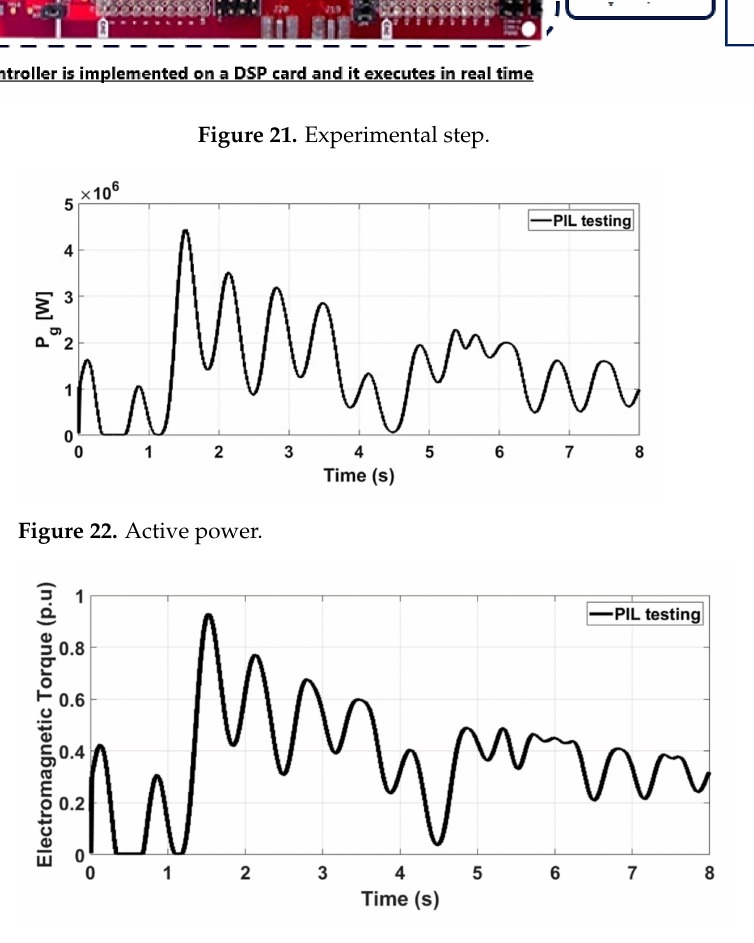
Figure 23. Electromagnetic